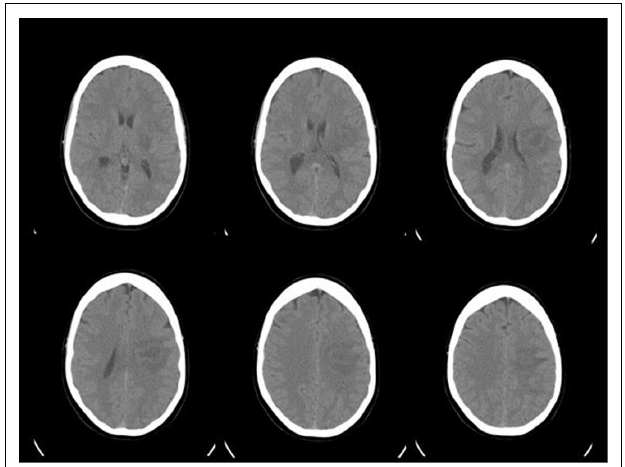
FIGURE 1 | Non-contrast cranial CT upon